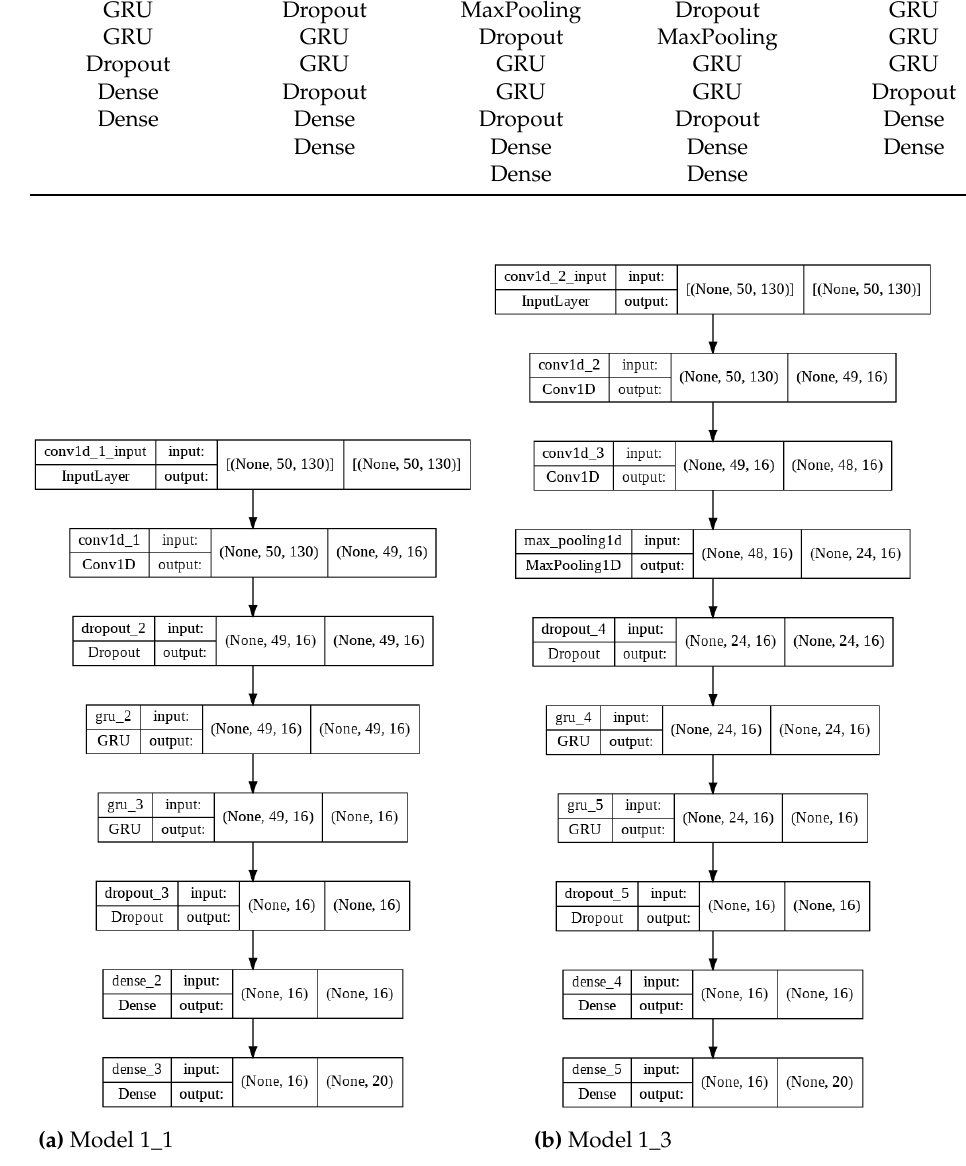
Figure 4. Graphical representations of two models used in Experiment 1 with window size equal to 50, 16 filters, and 16 neurons.